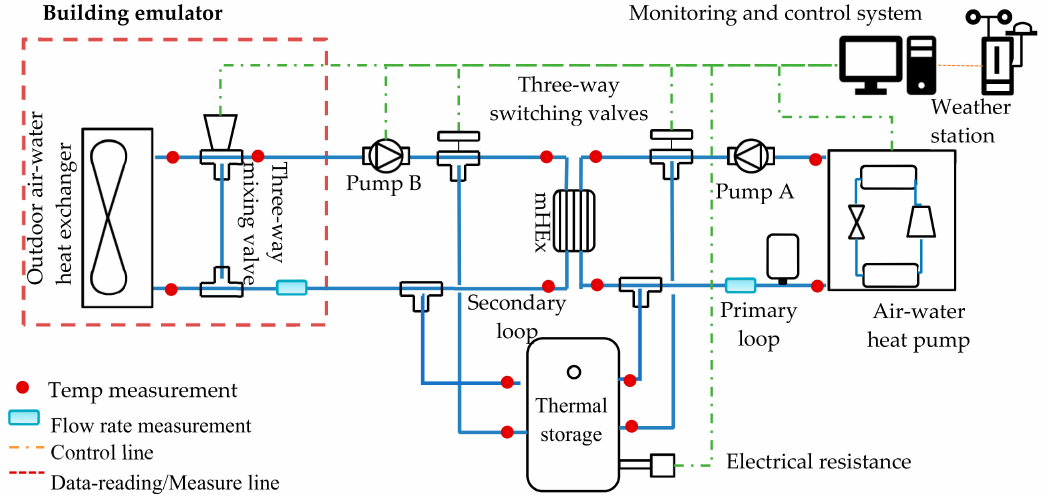
Figure 2. Layout and components of the BE-IES “hardware-in-the-loop”